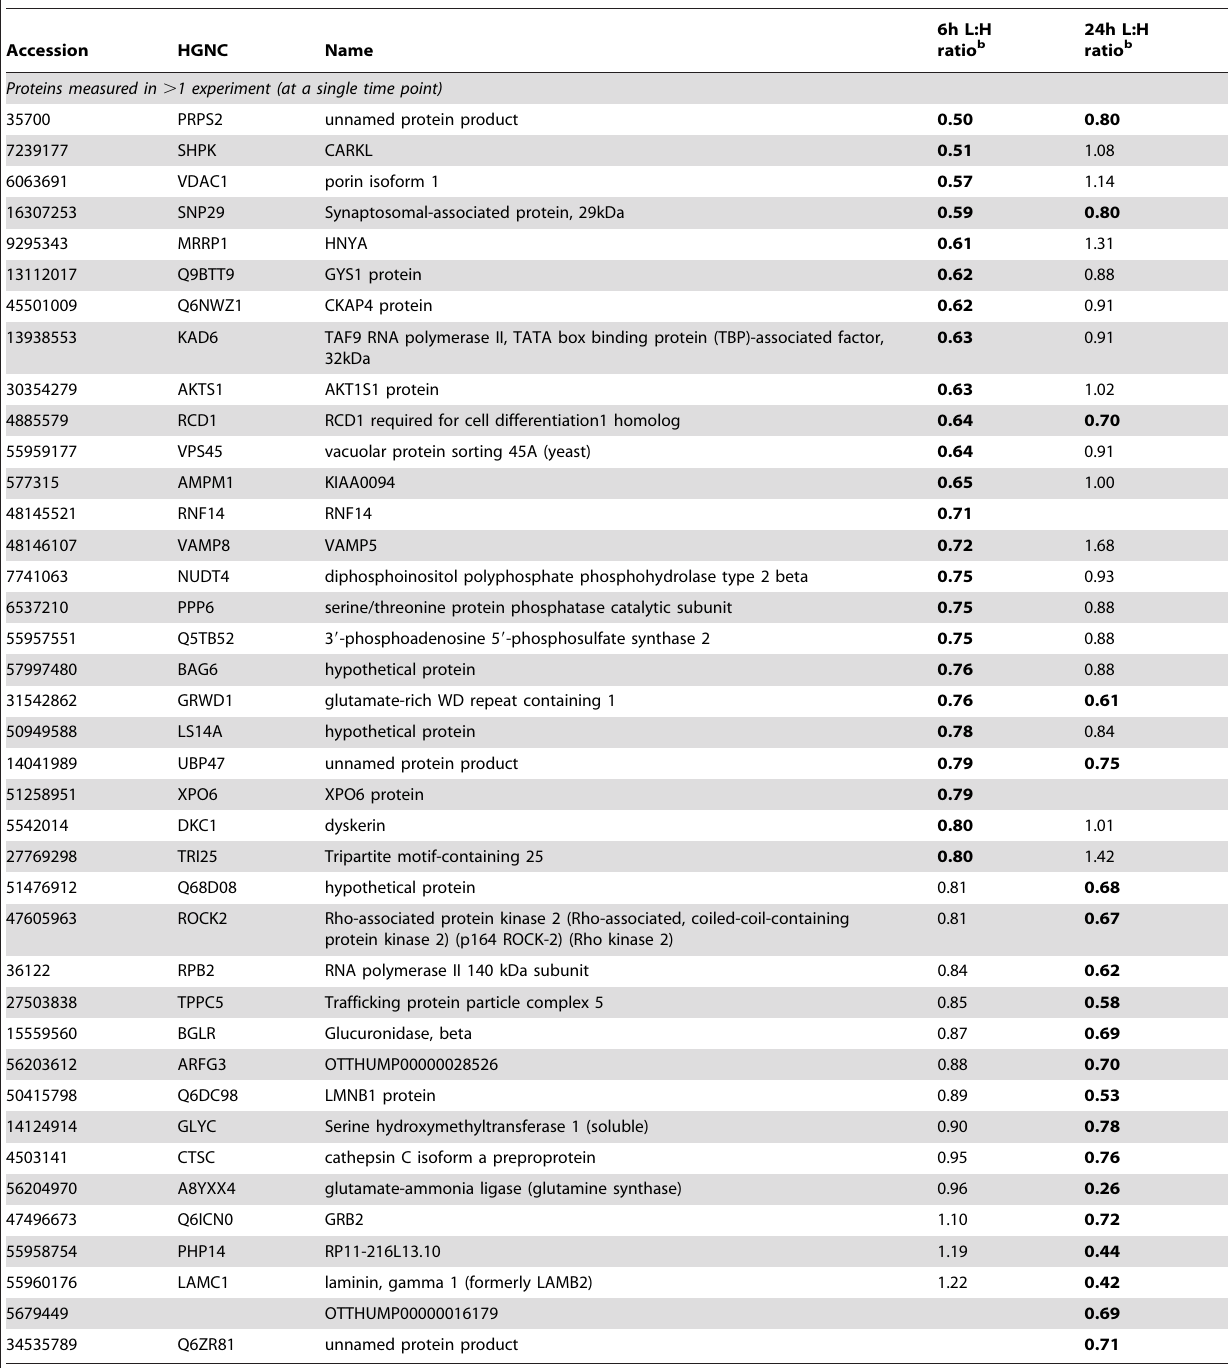
Table 2. HEK293 proteins decreased . 95% confidence a